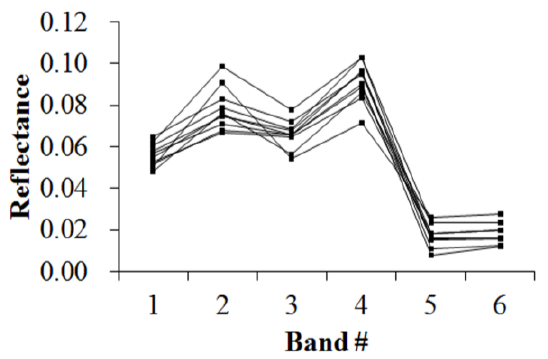
Table 9. Identification template 2 for water class.